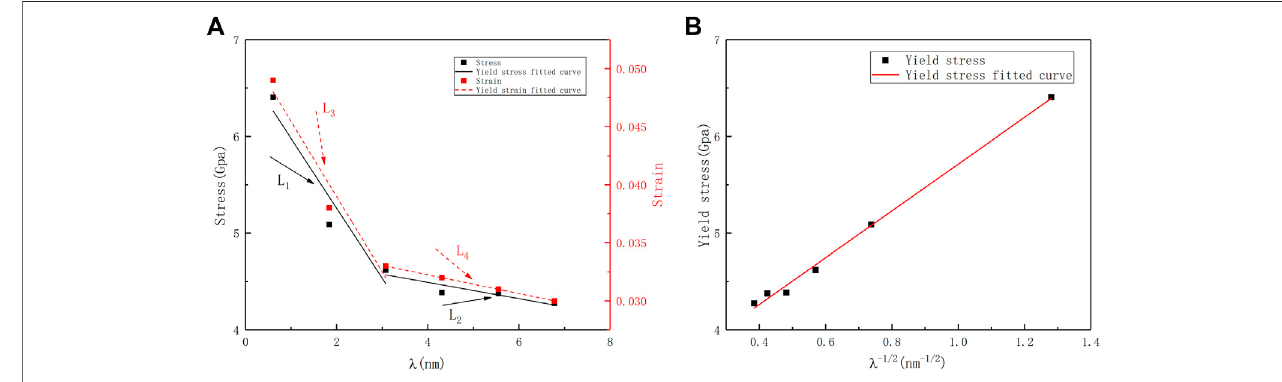
FIGURE 3 | (A) Evolutions of the yield stress and yield strain of the nt-HEAs with the twin boundary spacing. (B) The relationship between yield stress and λ − 1/2 .